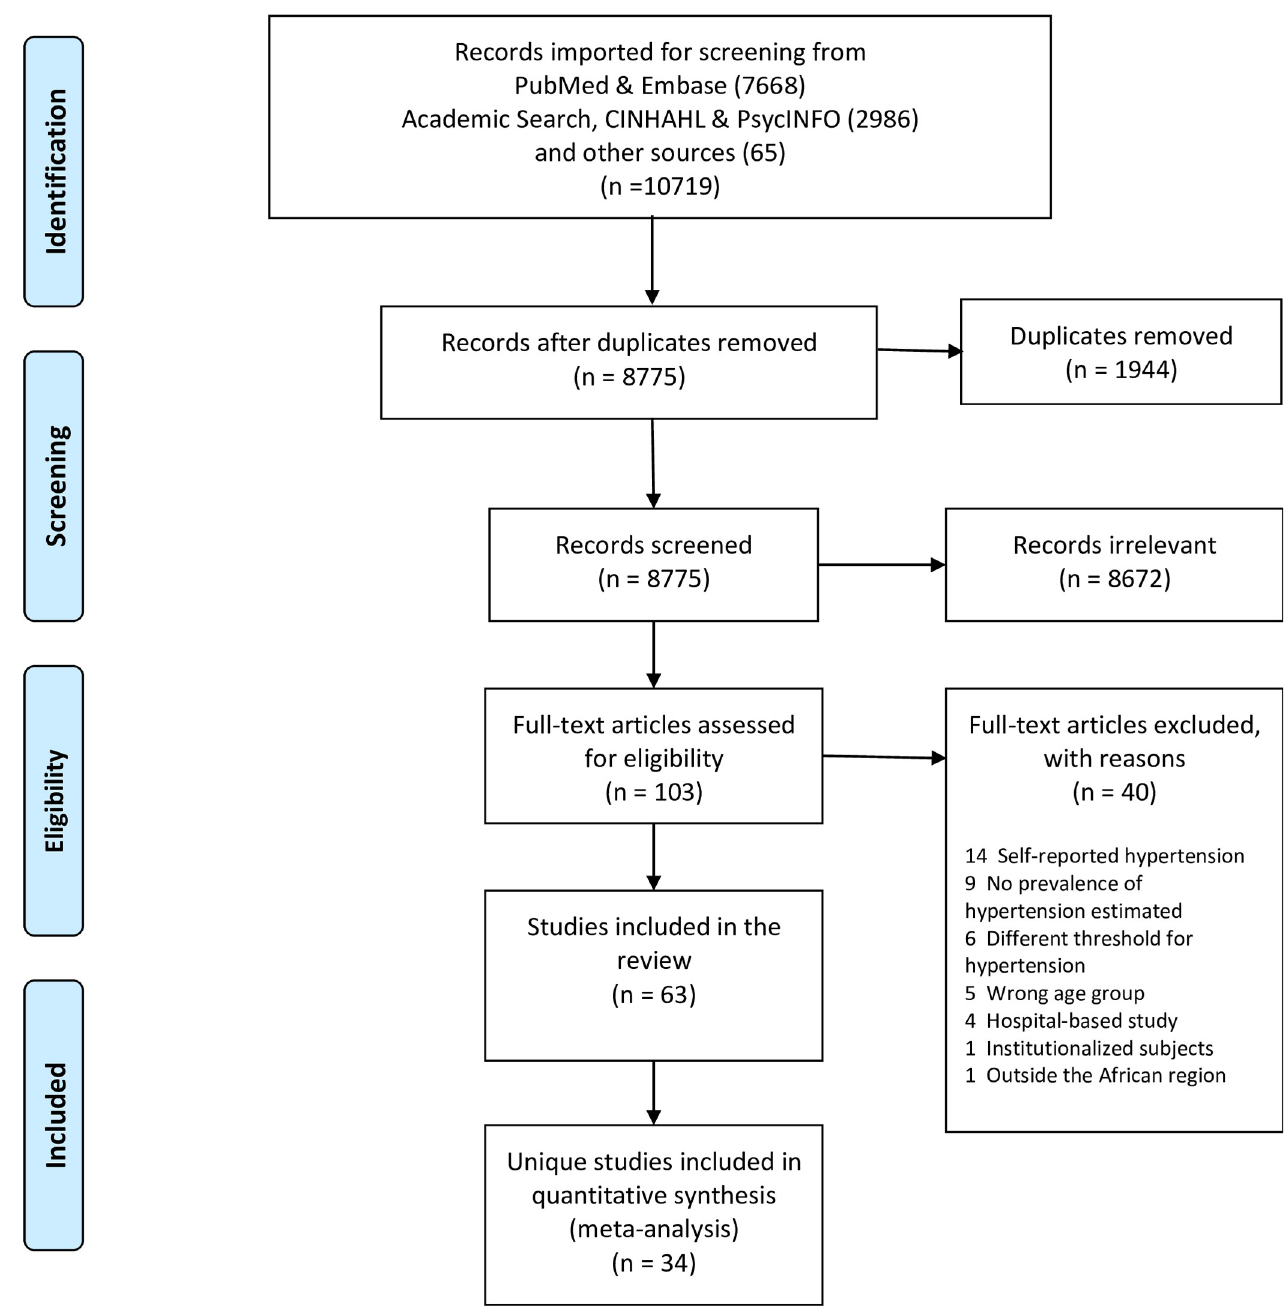
Fig 1. PRISMA flow diagram showing study